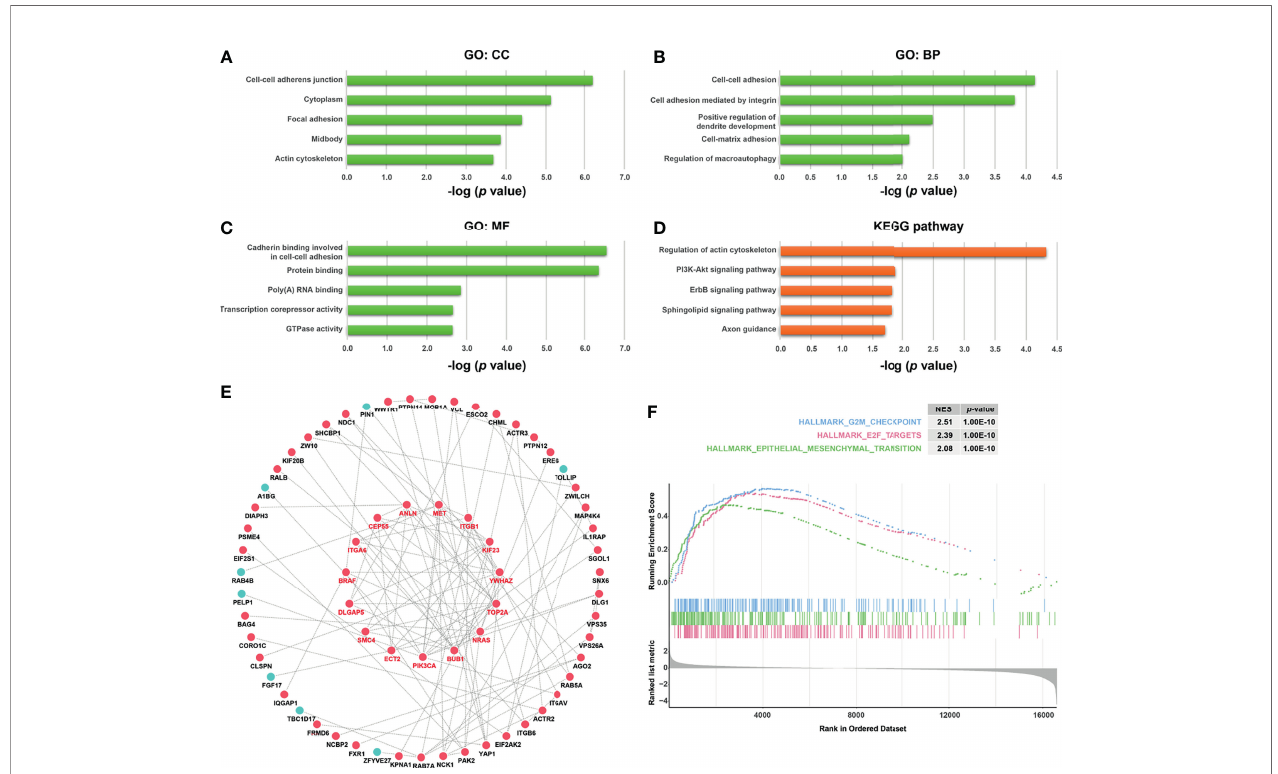
FIGURE 6 | Functional analysis of KPNA4 by GO, KEGG pathway, PPI network and GSEA. GO analysis comprising cellular component (CC, A ), biological process (BP, B ) and molecular function (MF, C ), and KEGG pathway analysis (D) were conducted on KPNA4 co-expressed genes in TCGA PDAC. A PPI network was constructed by Cytoscape software based on these co-expressed genes, and the hub genes were calculated and presented in the form of circle in the middle of (E) . GSEA was carried out to compare the expression pro fi les between low- KPNA4 and high- KPNA4 samples in TCGA PDAC (F) . A p -value < 0.05 and FDR < 0.25 were considered to be a signi fi cantly enriched gene